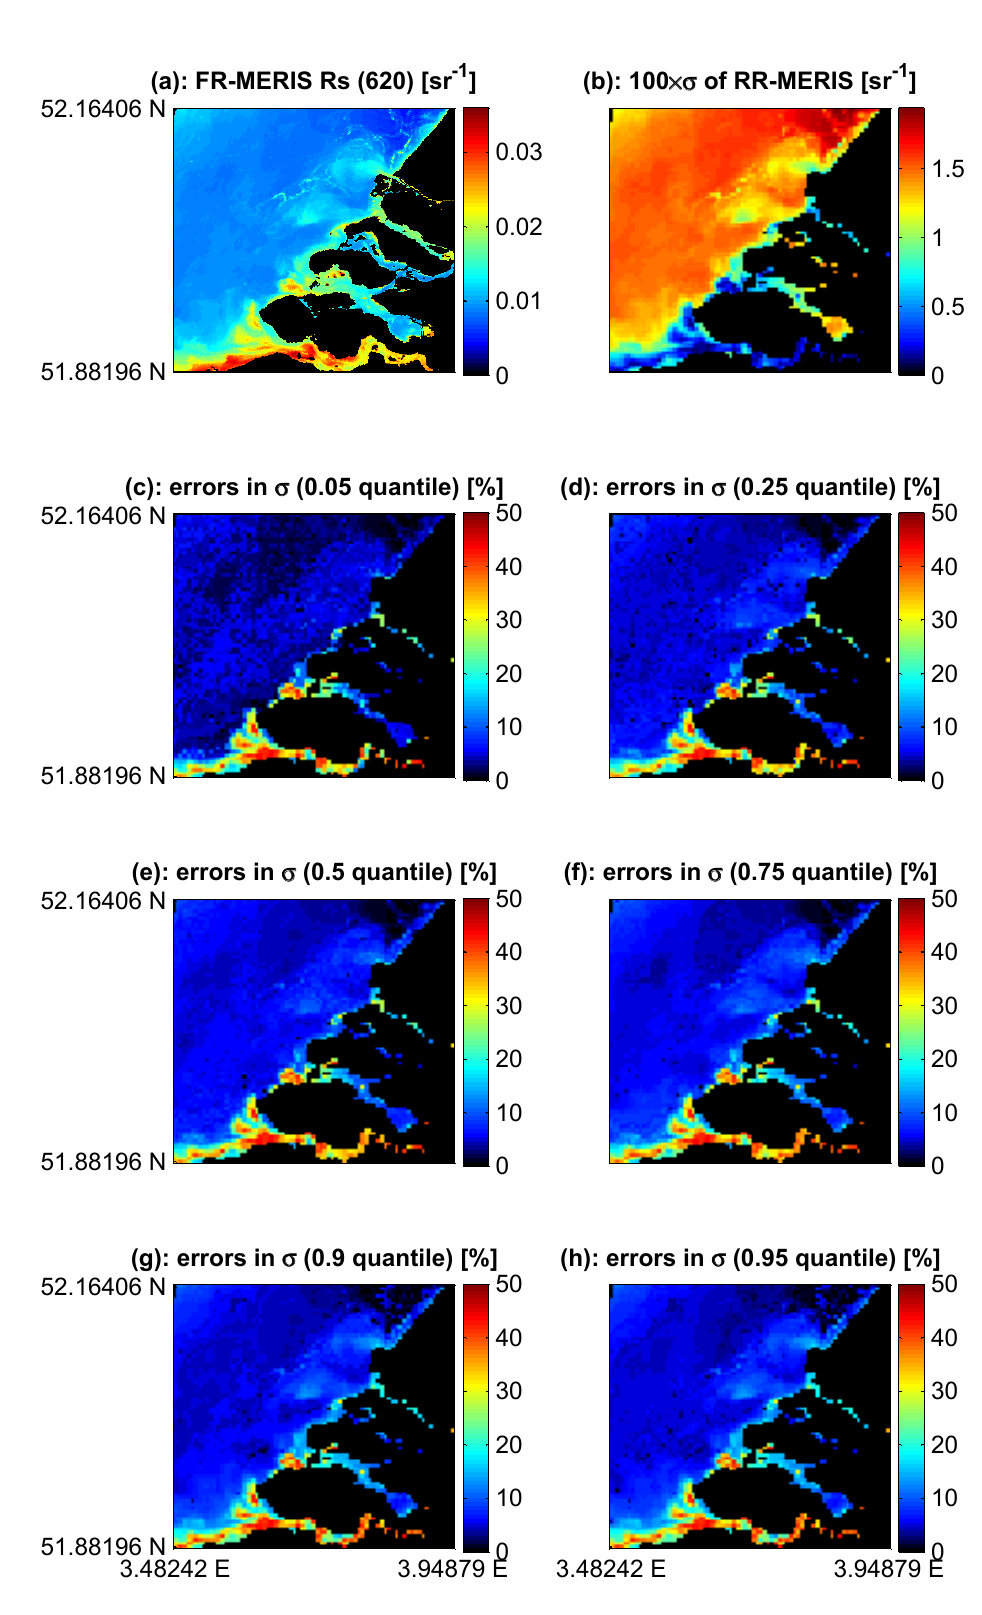
Figure 5. (a) Remote sensing reflectance of MERIS full resolution (FR) band 6 centered at 620 nm; (b) derived standard deviation of the reduced resolution (RR) MERIS image using the FR pixels; (c-h) relative errors of derived (log) standard deviation values of RR-MERIS corresponding to quantiles 0.05, 0.25, 0.5, 0.75, 0.9 and